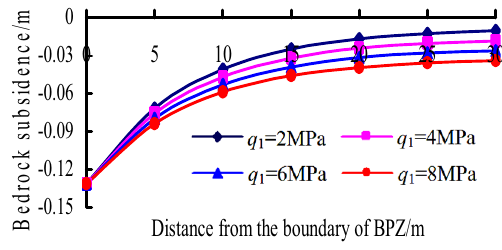
Figure 13. Bedrock subsidence vs. q igure in BPZ.